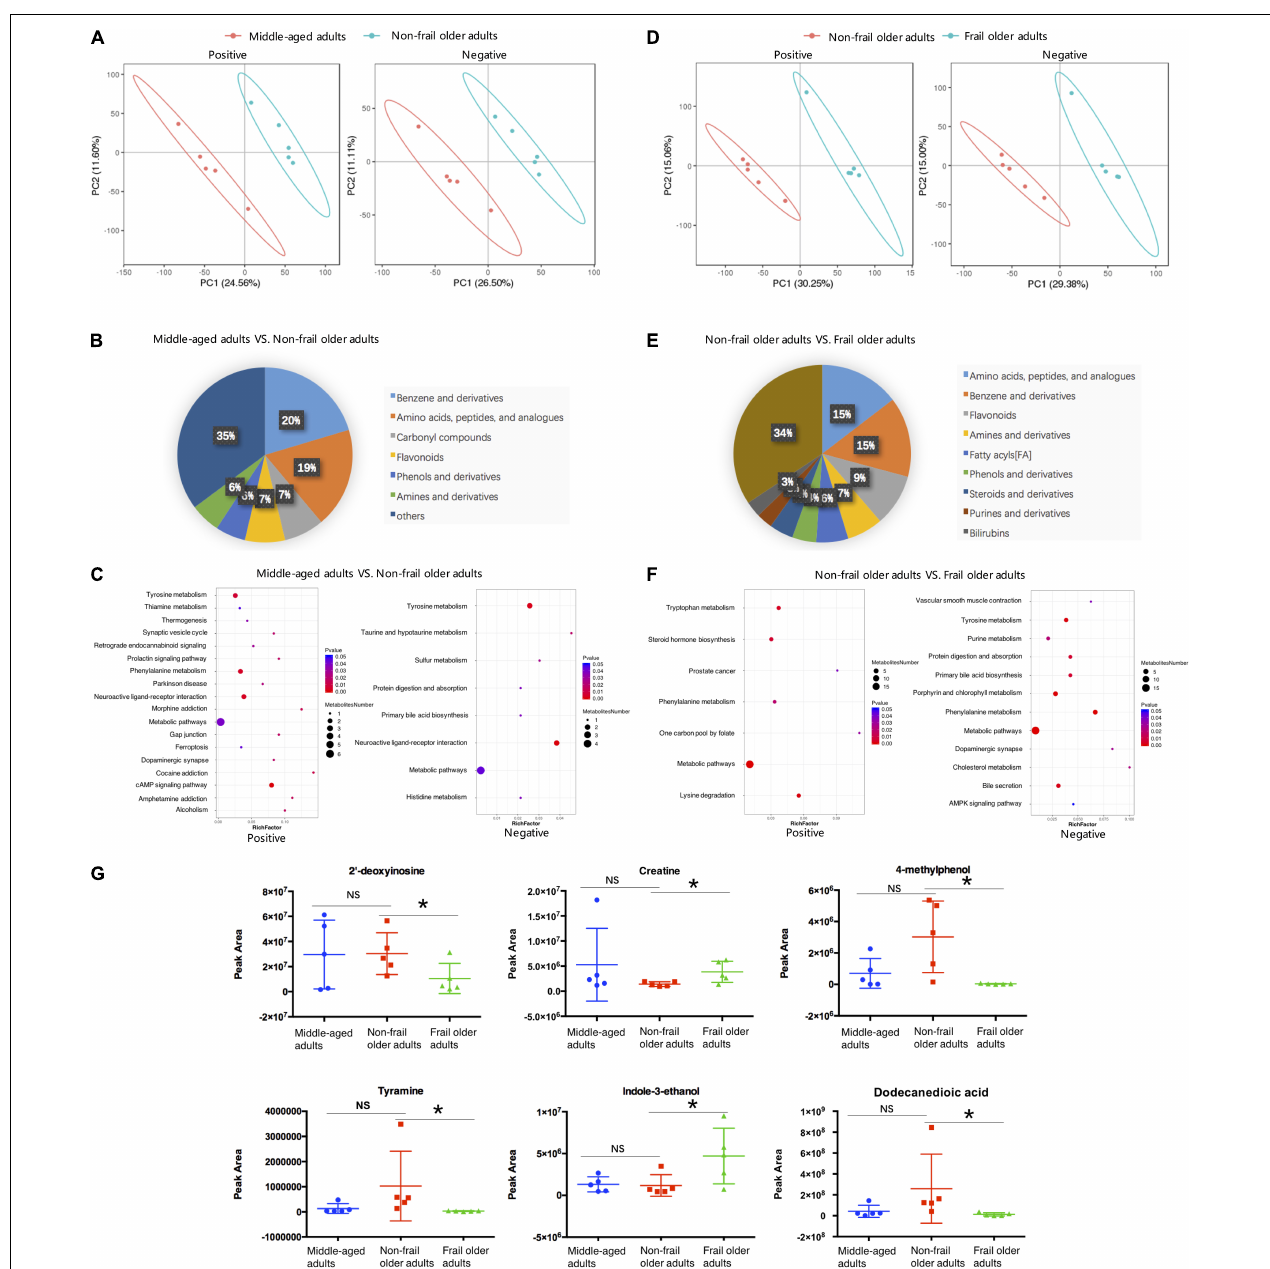
FIGURE 3 | Fecal metabolome analysis. (A,D) PLS-DA analysis of the grouped discrimination by the first two principal components (PCs) in positive (pos) and negative (neg) ion modes. (B,E) Pie graph of the metabolite class composition of significantly altered metabolites according to the number of metabolites in feces. (C,F) Bubble chart of pathway enrichment analysis of differential metabolites in positive (pos) and negative (neg) ion modes. RichFactor was the number of differential metabolites divided by all the identified metabolites annotated to the pathway. (G) Relative abundance of the differential metabolites related to the serum metabolites shown in Figure 2G . Peak Area: relative concentrations of metabolites. * p < 0.05. Error bars represented mean ±